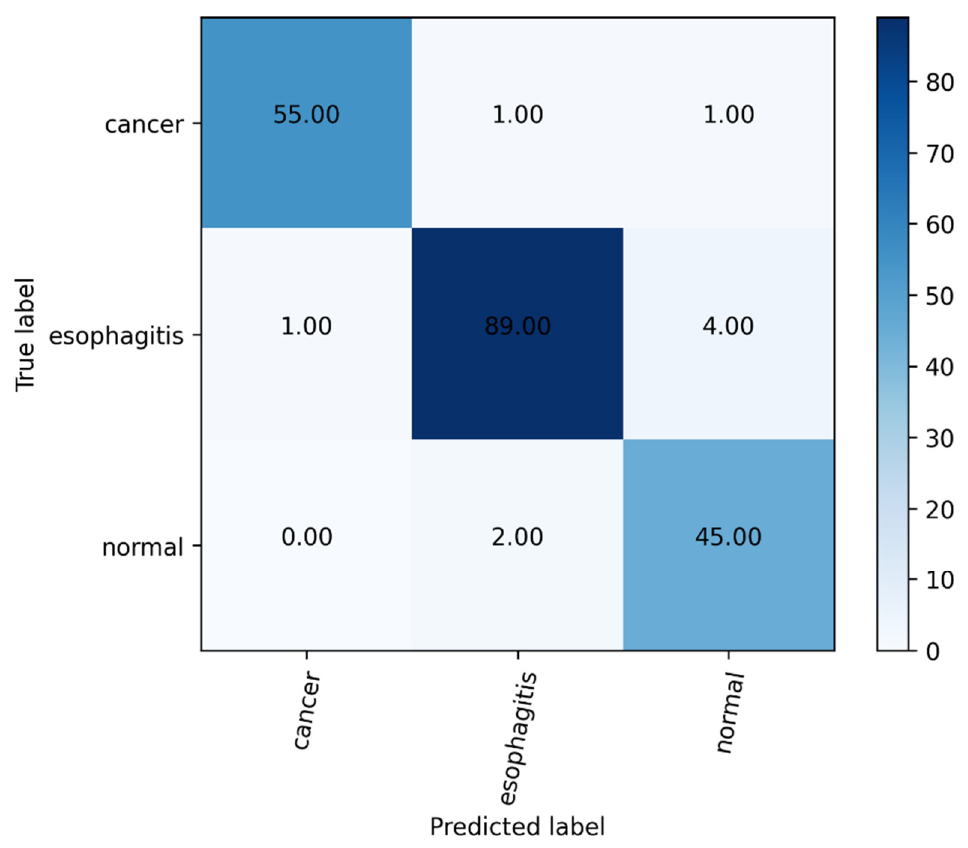
Figure 6. The confusion matrix of our model.